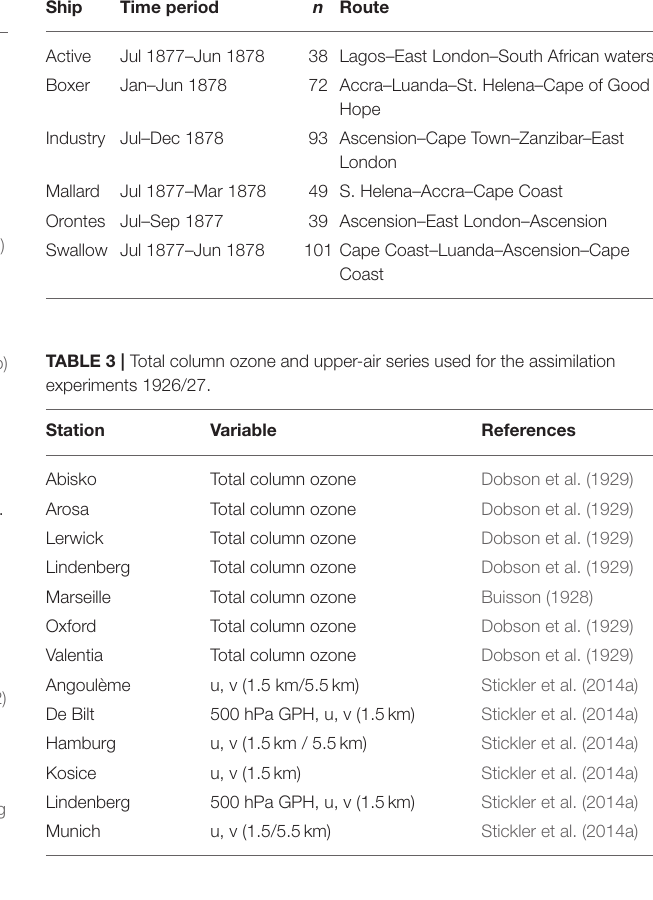
TABLE 1 | Stations used for the assimilation experiments 1807 (Var., variable, T, temperature, p, pressure; time indicates local time). Station